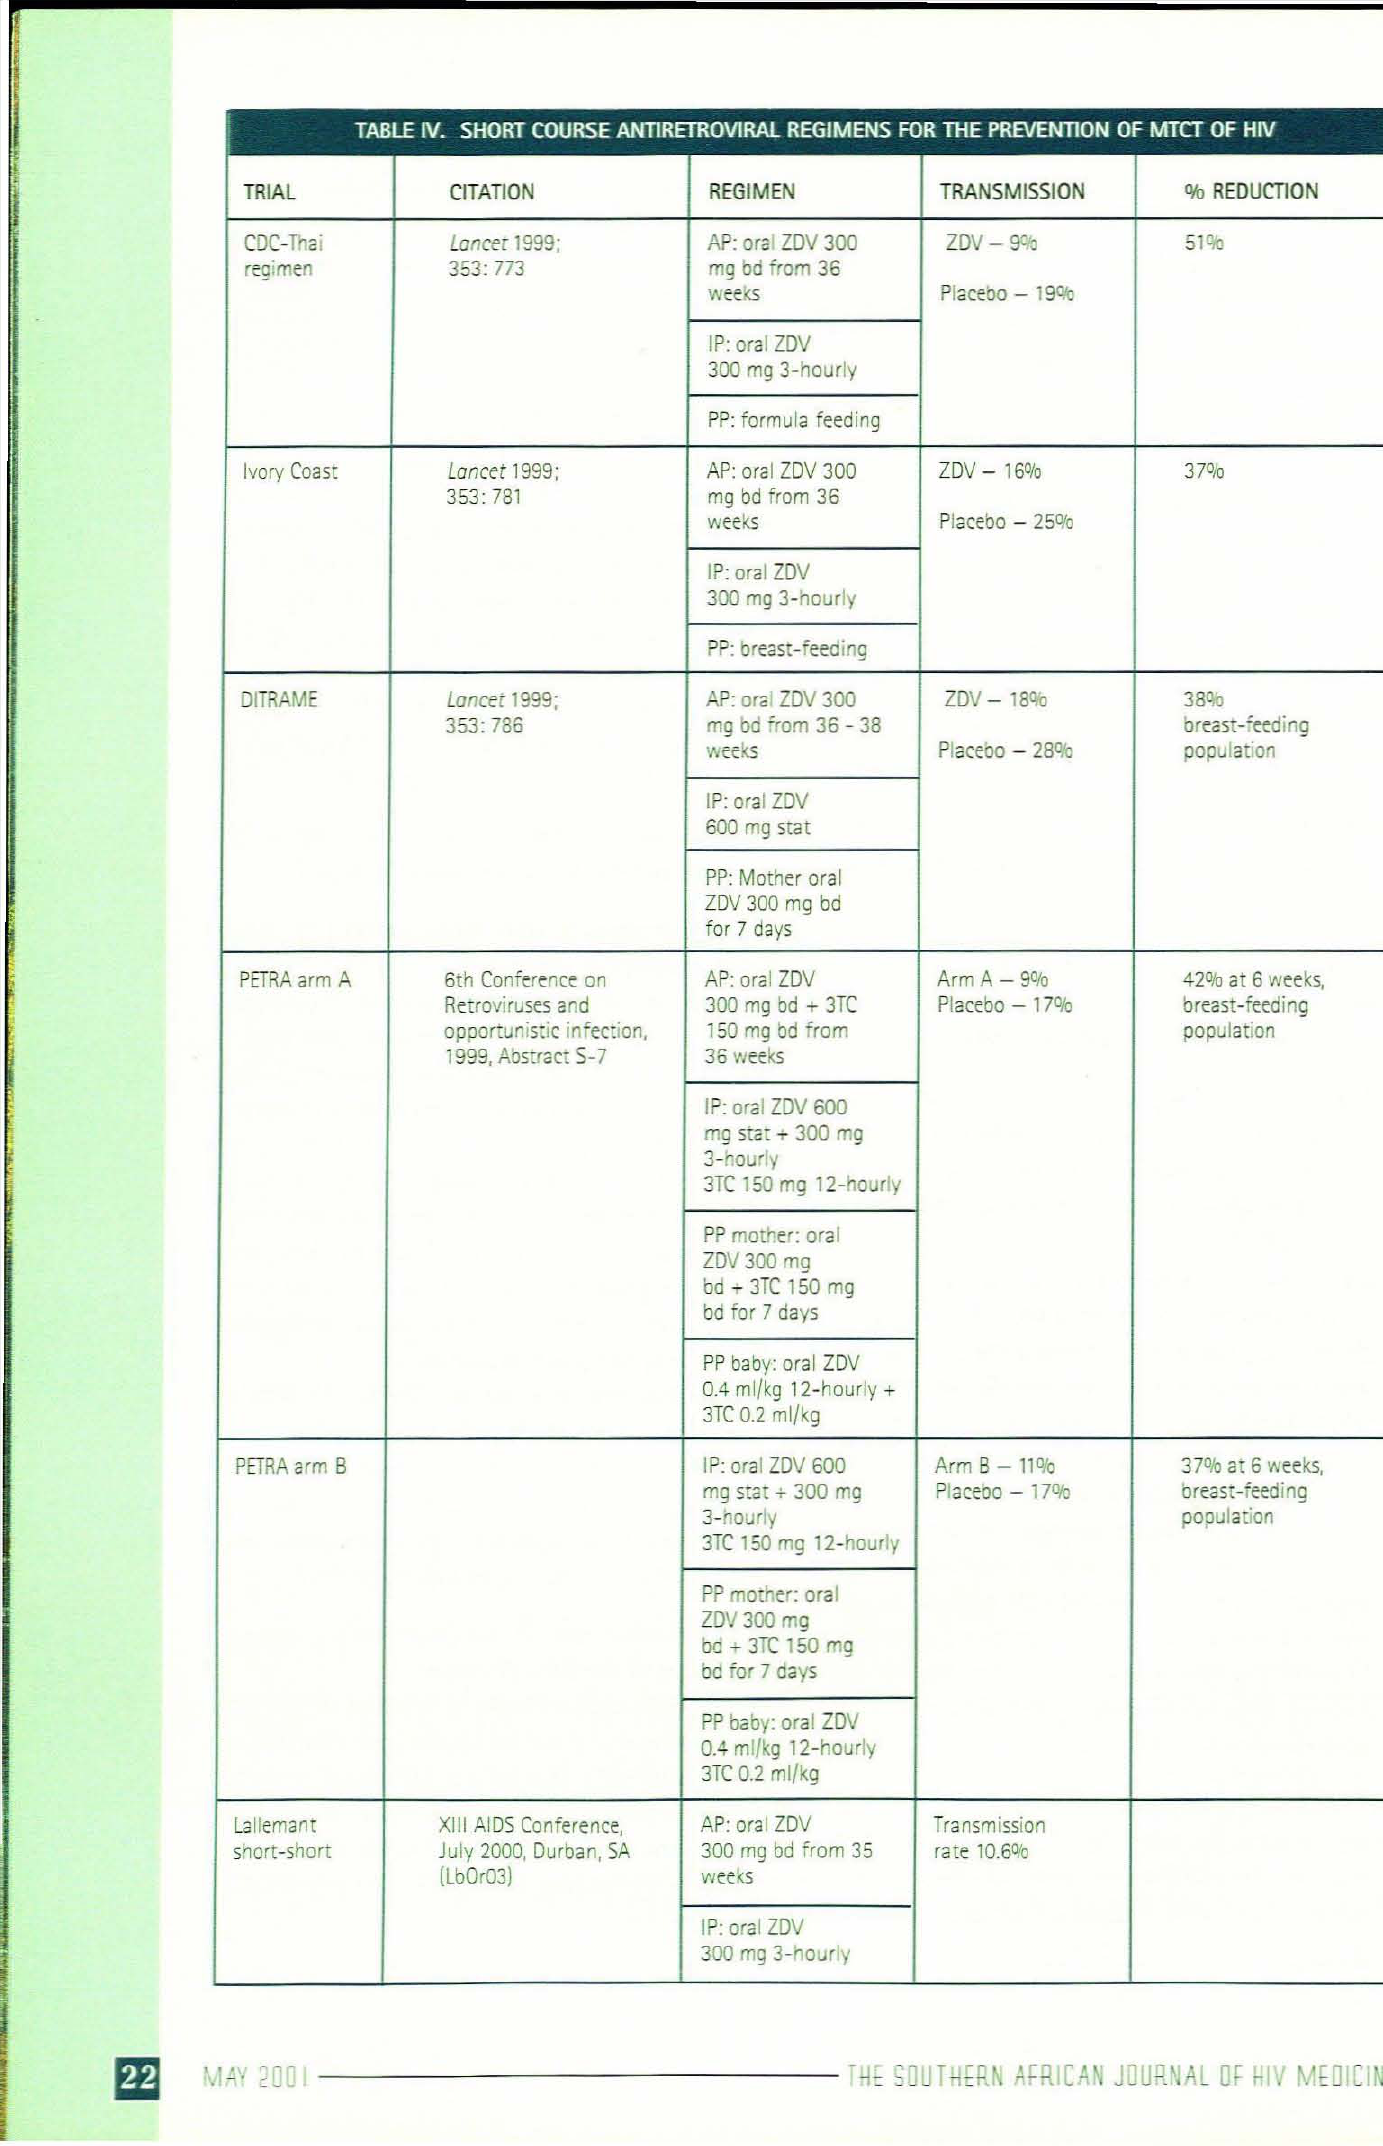
TABLE IV. SHORT COURSE ANTIRETROVIRAL REGIMENS FOR THE PREVENTlON OF MTCT OF HIV